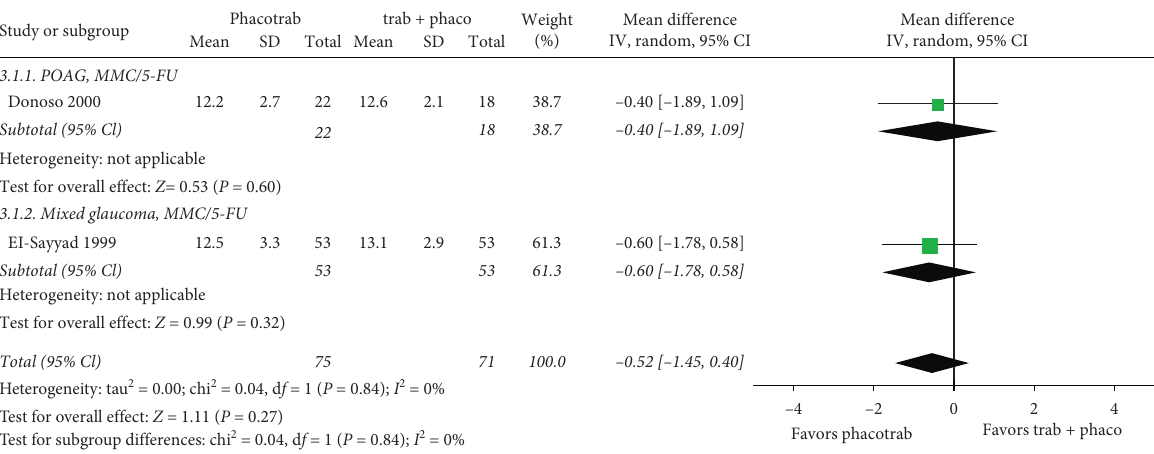
Figure 3: Forest plot of the IOP control postoperatively in eyes undergoing phacotrabeculectomy versus trabeculectomy with phaco- emulsification 3–6 months later. CI � confidence interval; df � degrees of freedom; IV � inverse variance; SD � standard deviation. MMC � mitomycin c; 5-FU � 5-fluorouracil; ± antimetabolite � not all eyes received antimetabolite.